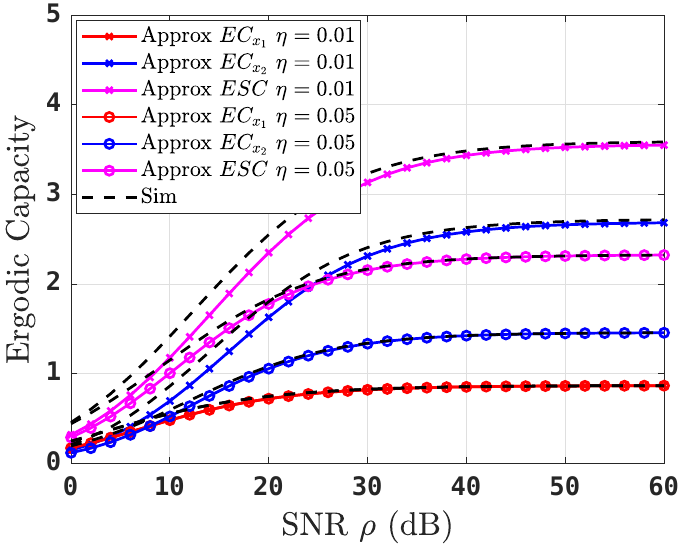
Figure 7. ECs versus SNR for thermally uniform salty UOWC links at BL = 2.4 L/min for varying values of η .